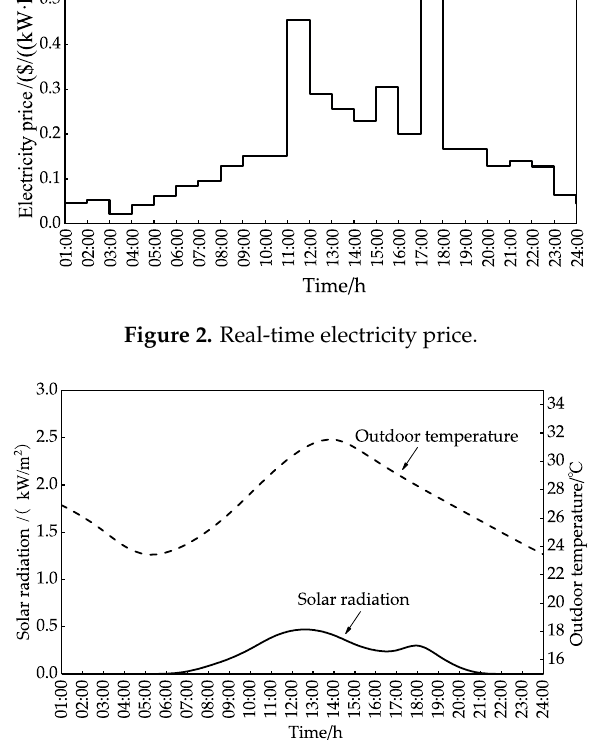
Figure 3. Solar radiation and outdoor temperature.